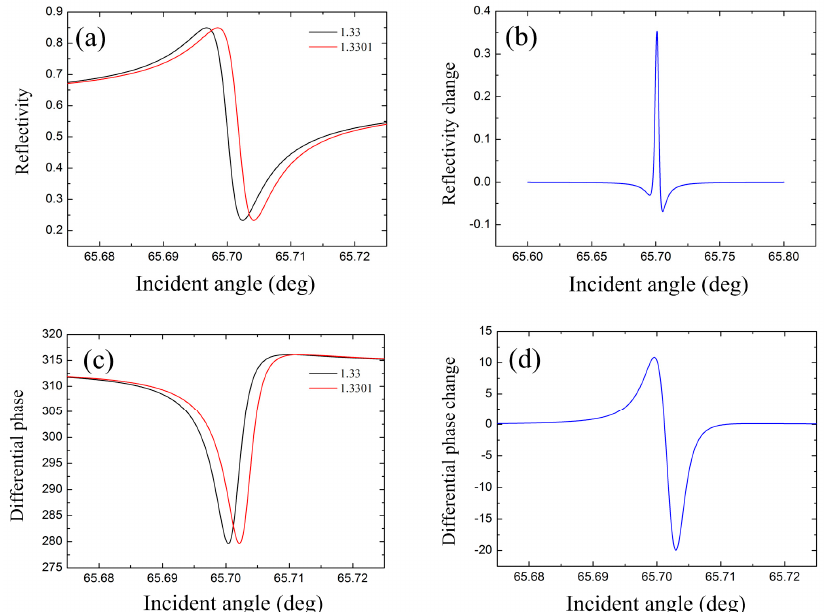
Figure 5. ( a , c ) Reflectivity and differential phase versus incident angle under probing sampling RI of 1.33 and 1.3301, and ( b , d ) the corresponding reflectivity and differential phase change. ( t 1 = 110 nm, t 2 = 700 nm, and t 3 = 250 nm).